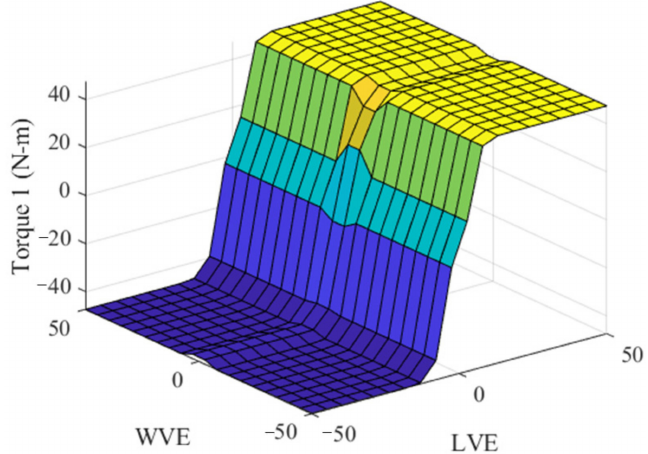
Figure 8. Torque 1